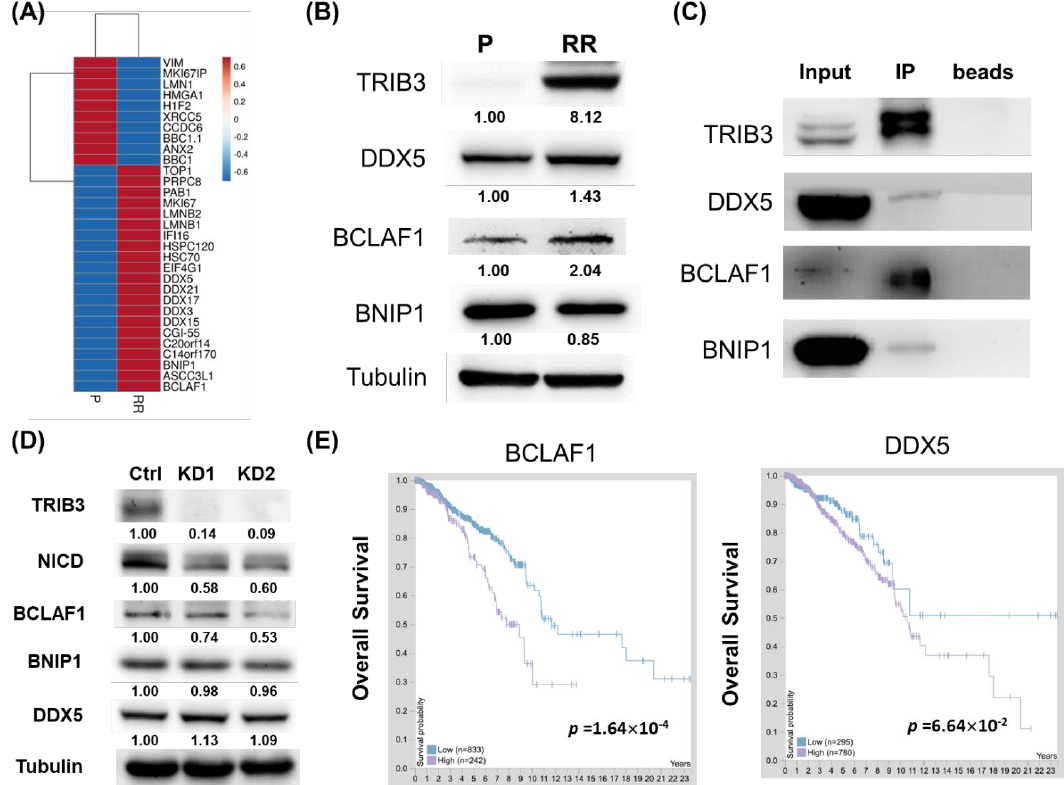
Figure 5. BCL2-associated transcription factor 1 (BCLAF1), BCL2 interacting protein 1 (BNIP1),